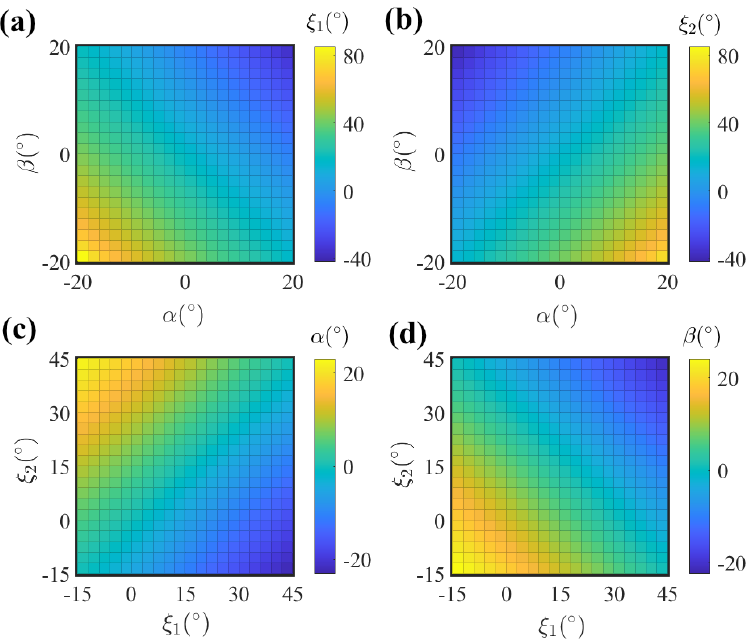
Figure 7. The numerical solution of the parallel control mechanism. ( a , b ) indicate the inverse kinematics solution. ( c , d ) indicate the forward kinematics solution.